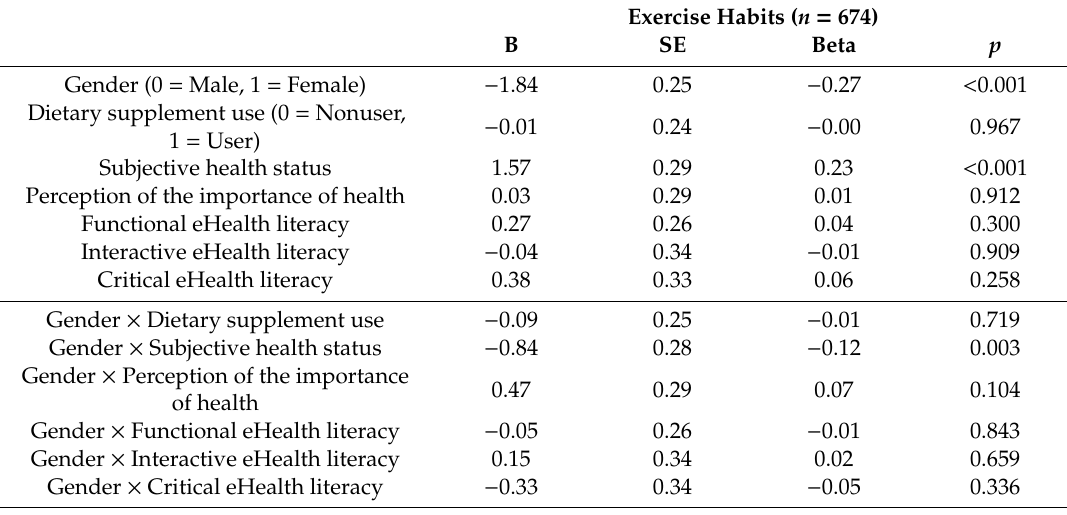
Table 3. Hierarchical regression analysis of exercise